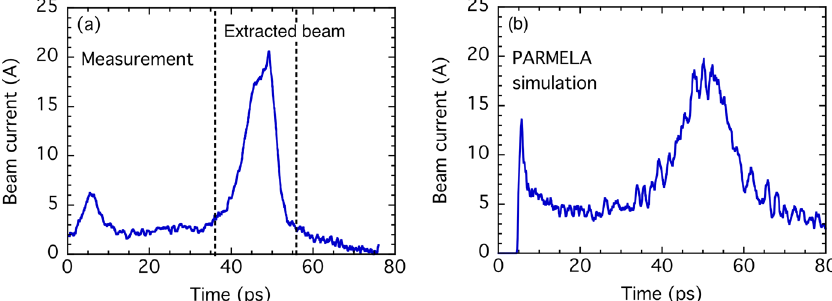
FIG. 10. Longitudinal bunch profiles at the injector exit. (a) Measured longitudinal current distribution at the injector exit. The peak current and bunch length are 20 A and 8.8 ps (FWHM), respectively. (b) Longitudinal current distribution at the injector exit simulated by PARMELA code.